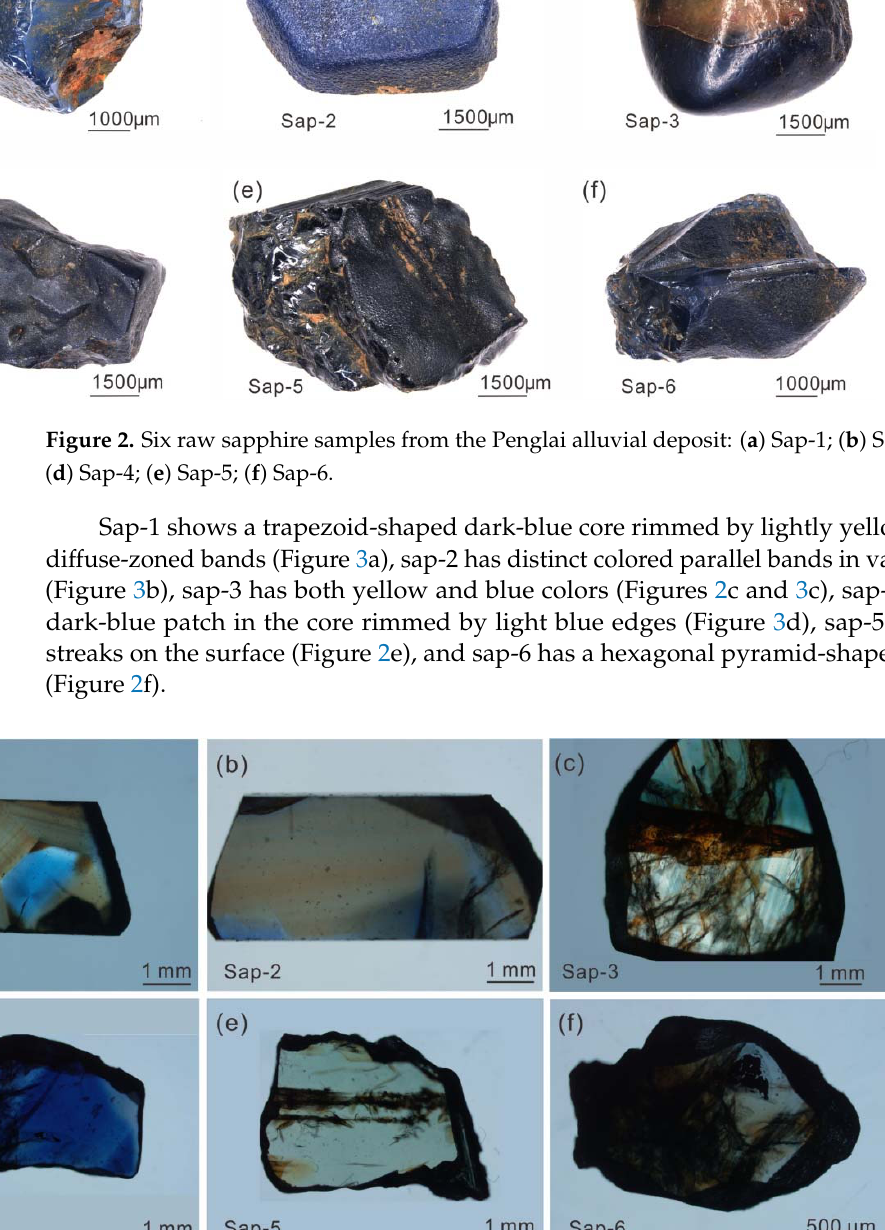
Figure 3. The cut and polished sapphire samples from the Penglai alluvial deposit: ( a ) Sap ‐ 1; ( b ) Sap ‐ 2; ( c ) Sap ‐ 3; ( d ) Sap ‐ 4; ( e ) Sap ‐ 5; ( f ) Sap ‐ 6.